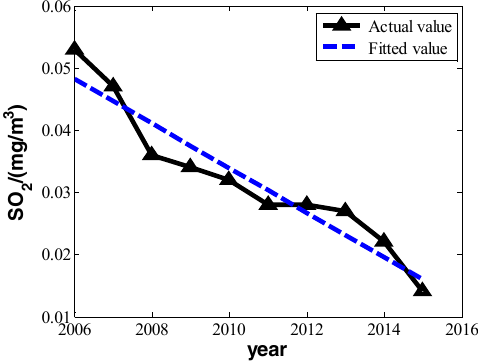
Int. J. Environ. Res. Public Health 2018 , 15 , x Picture 2. The change in the annual daily mean of sulfur dioxide from 2006 to 2015. Figure 2. The change in the annual daily mean of sulfur dioxide from 2006 to 2015. Picture 2. The change in the annual daily mean of sulfur dioxide from 2006 to 2015.